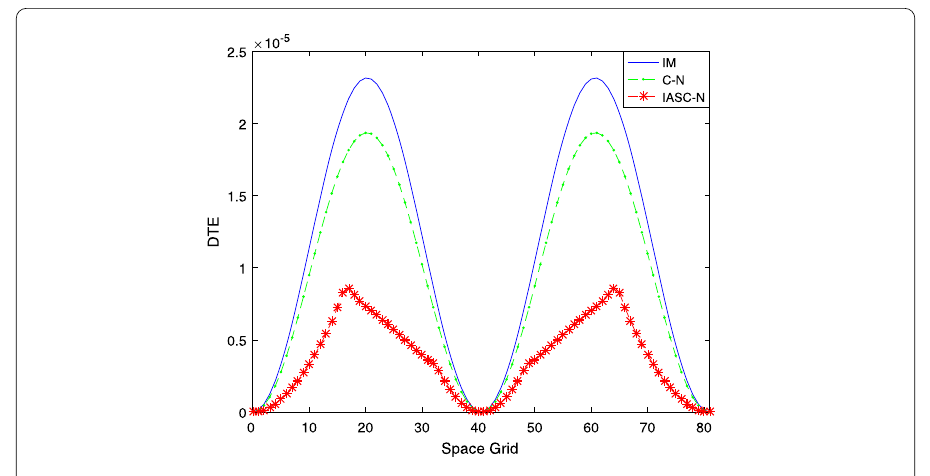
Figure 8 DTE curves of three schemes ( α = 0.7)